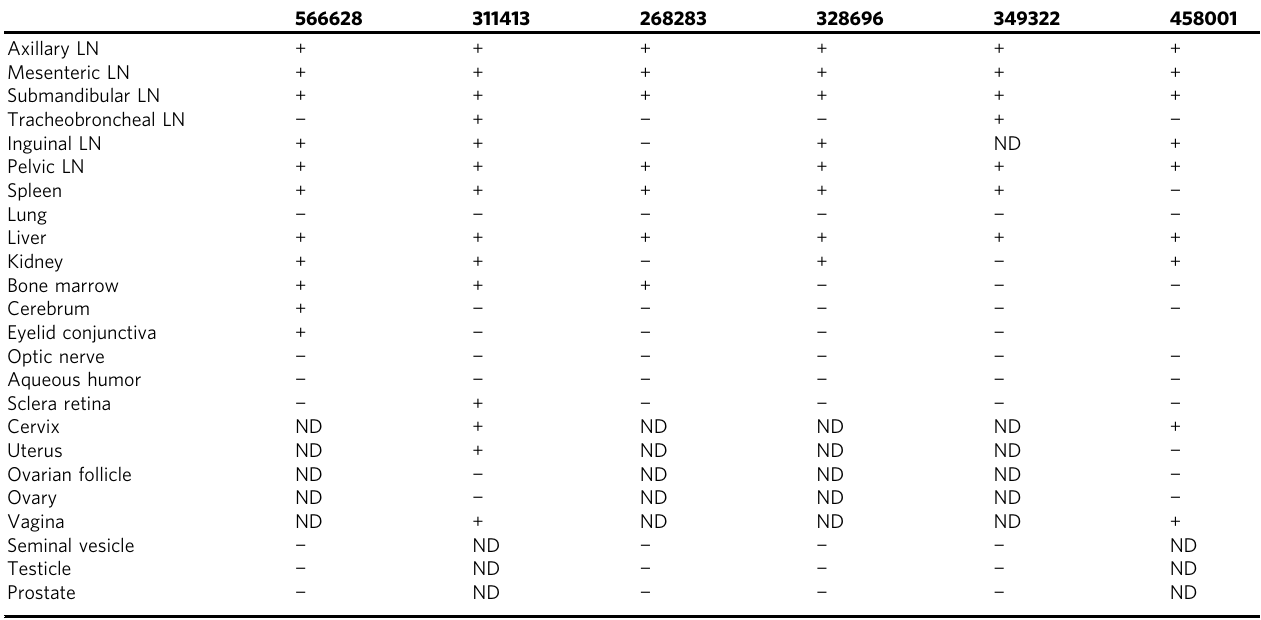
Table 2 Complete list of tissues examined for ZIKV